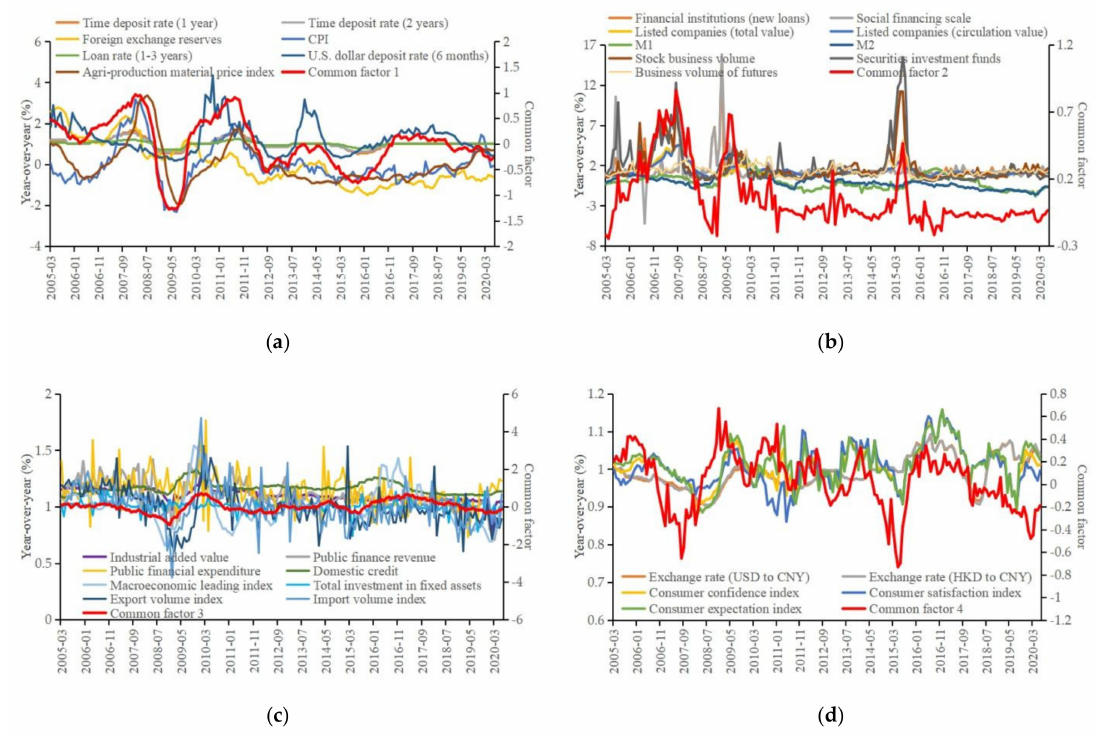
Figure 4. Four common factors of economic uncertainties. ( a ) Common factor 1 and related variables. ( b ) Common factor 2 and related variables. ( c ) Common factor 3 and related variables. ( d ) Common factor 4 and related variables. Note: In order to describe the trend between common factors and related variables clearly, some variables related to each common factor are selected as representatives for display.